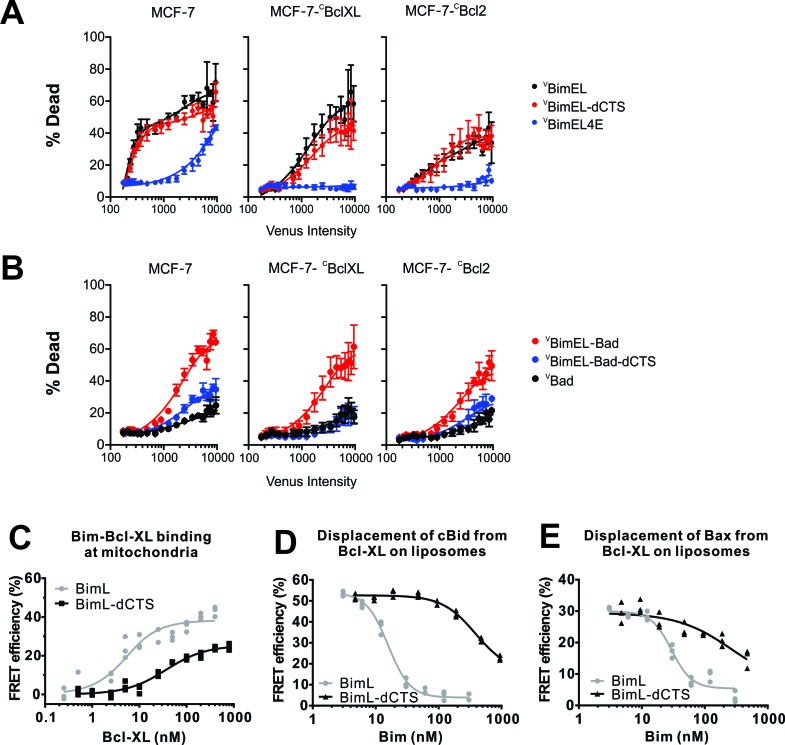
The CTS contributes to Bim mediated inhibition of Bcl-XL and Bcl-2.The BH3-proteins indicated to the right of the panels were expressed by transient transfection in MCF-7 cells and MCF-7 cells stably expressing either CBcl-XL or CBcl-2, as indicated. Commitment to cell death (% Dead) was assessed for individual cells using a linear classifier trained on both cell and nuclear morphology and TMRE intensity. Venus intensity was used to estimate for individual cells the relative BH3 protein expression and to divide them into bins with similar expression levels. For each bin, the % of cells classified as dead or dying (% Dead) is represented by the means from three replicates (colored dots); bars indicate standard error of the means. (A) Transient expression of pro-apoptotic BH3 proteins killed MCF-7 cells in an expression level dependent manner that was inhibited by exogenous expression of CBcl-XL and CBcl-2 (black lines). Deletion of the CTS of BimEL did not inhibit induction of cell death resulting from expression of BimEL in all 3 cell lines (red lines). High level expression of BimEL-4E killed MCF-7 cells in a manner completely inhibited by exogenous expression of either anti-apoptotic protein (navy blue lines). (B) The BH3 protein VBimEL-Bad that is unable to bind MCL-1 has reduced cell killing activity in MCF-7 cells that depends on the BIM CTS sequence and is poorly inhibited by exogenous expression of Bcl-XL or Bcl-2. Expression level dependent cell death was equivalent for VBimEL-Bad-dCTS and Bad consistent with MCF-7 cells being protected by endogenous MCL-1. (C–E) Interactions of Bcl-XL with BimL, BimL-dCTS, tBid and Bax measured using FRET. Data from three independent experiments are shown as individual points, some of which are not visible due to overlap. (C) The CTS of BimL increases its affinity for Bcl-XL. Binding of 4 nM Alexa568-labeled BimL or BimL-dCTS to the indicated amounts of Alexa647-labeled Bcl-XL was measured by FRET in samples containing mouse liver mitochondria. The resultant apparent Kd values for binding to Bcl-XL by BimL and BimL-dCTS, 3 ± 1 nM and 35 ± 5 nM, respectively are both well below the concentrations of the proteins expressed in cells. (D) The CTS of BimL increases displacement of Bid from Bcl-XL. Binding of cBid to membranes displaces the N-terminal region and the remaining tBid portion containing the BH3 region binds to membranes and anti-apoptotic proteins. Complexes of Alexa568-labeled cBid (4 nM) and Alexa647-labeled Bcl-XL (10 nM) were formed in incubations containing 2.9 nM liposomes. Displacement of cBid from Bcl-XL was measured by loss of FRET between Alexa568-labeled cBid and Alexa647-labeled Bcl-XL upon addition of the indicated concentrations of BimL or BimL-dCTS. (E) The CTS of BimL increases displacement of Bax from Bcl-XL. Bim mediated displacement of Bax from Bcl-XL was measured as in (d) except that complexes between Bcl-XL and Bax were assembled from Alexa568-labeled Bax (10 nM), a Bid mutant that activates Bax but does not bind Bcl-XL (10 nM cBidmt1), Alexa647-labeled Bcl-XL (30 nM), 2.9 nM liposomes and the indicated concentrations of BimL or BimL-dCTS. Because in these reactions 30 nM Bcl-XL was required to bind 10 nM Bax saturably as opposed to the 10 nM Bcl-XL used in (d) the concentrations of BimL and BimL-dCTS needed to displace Bax are higher than for displacement of tBid in experiments with added cBid. The curves are further complicated because the displaced Bax can also bind to BimL and BimL-dCTS. Thus while these data demonstrate that both BimL and BimL-dCTS displace Bax from Bcl-XL the curves are difficult to interpret in terms of binding constants.10.7554/eLife.37689.022Figure 5—source data 1.Multiparametric cell death data for the mutants demonstrating that the Bim CTS contributes to Bim mediated inhibition of Bcl-XL and Bcl-2.